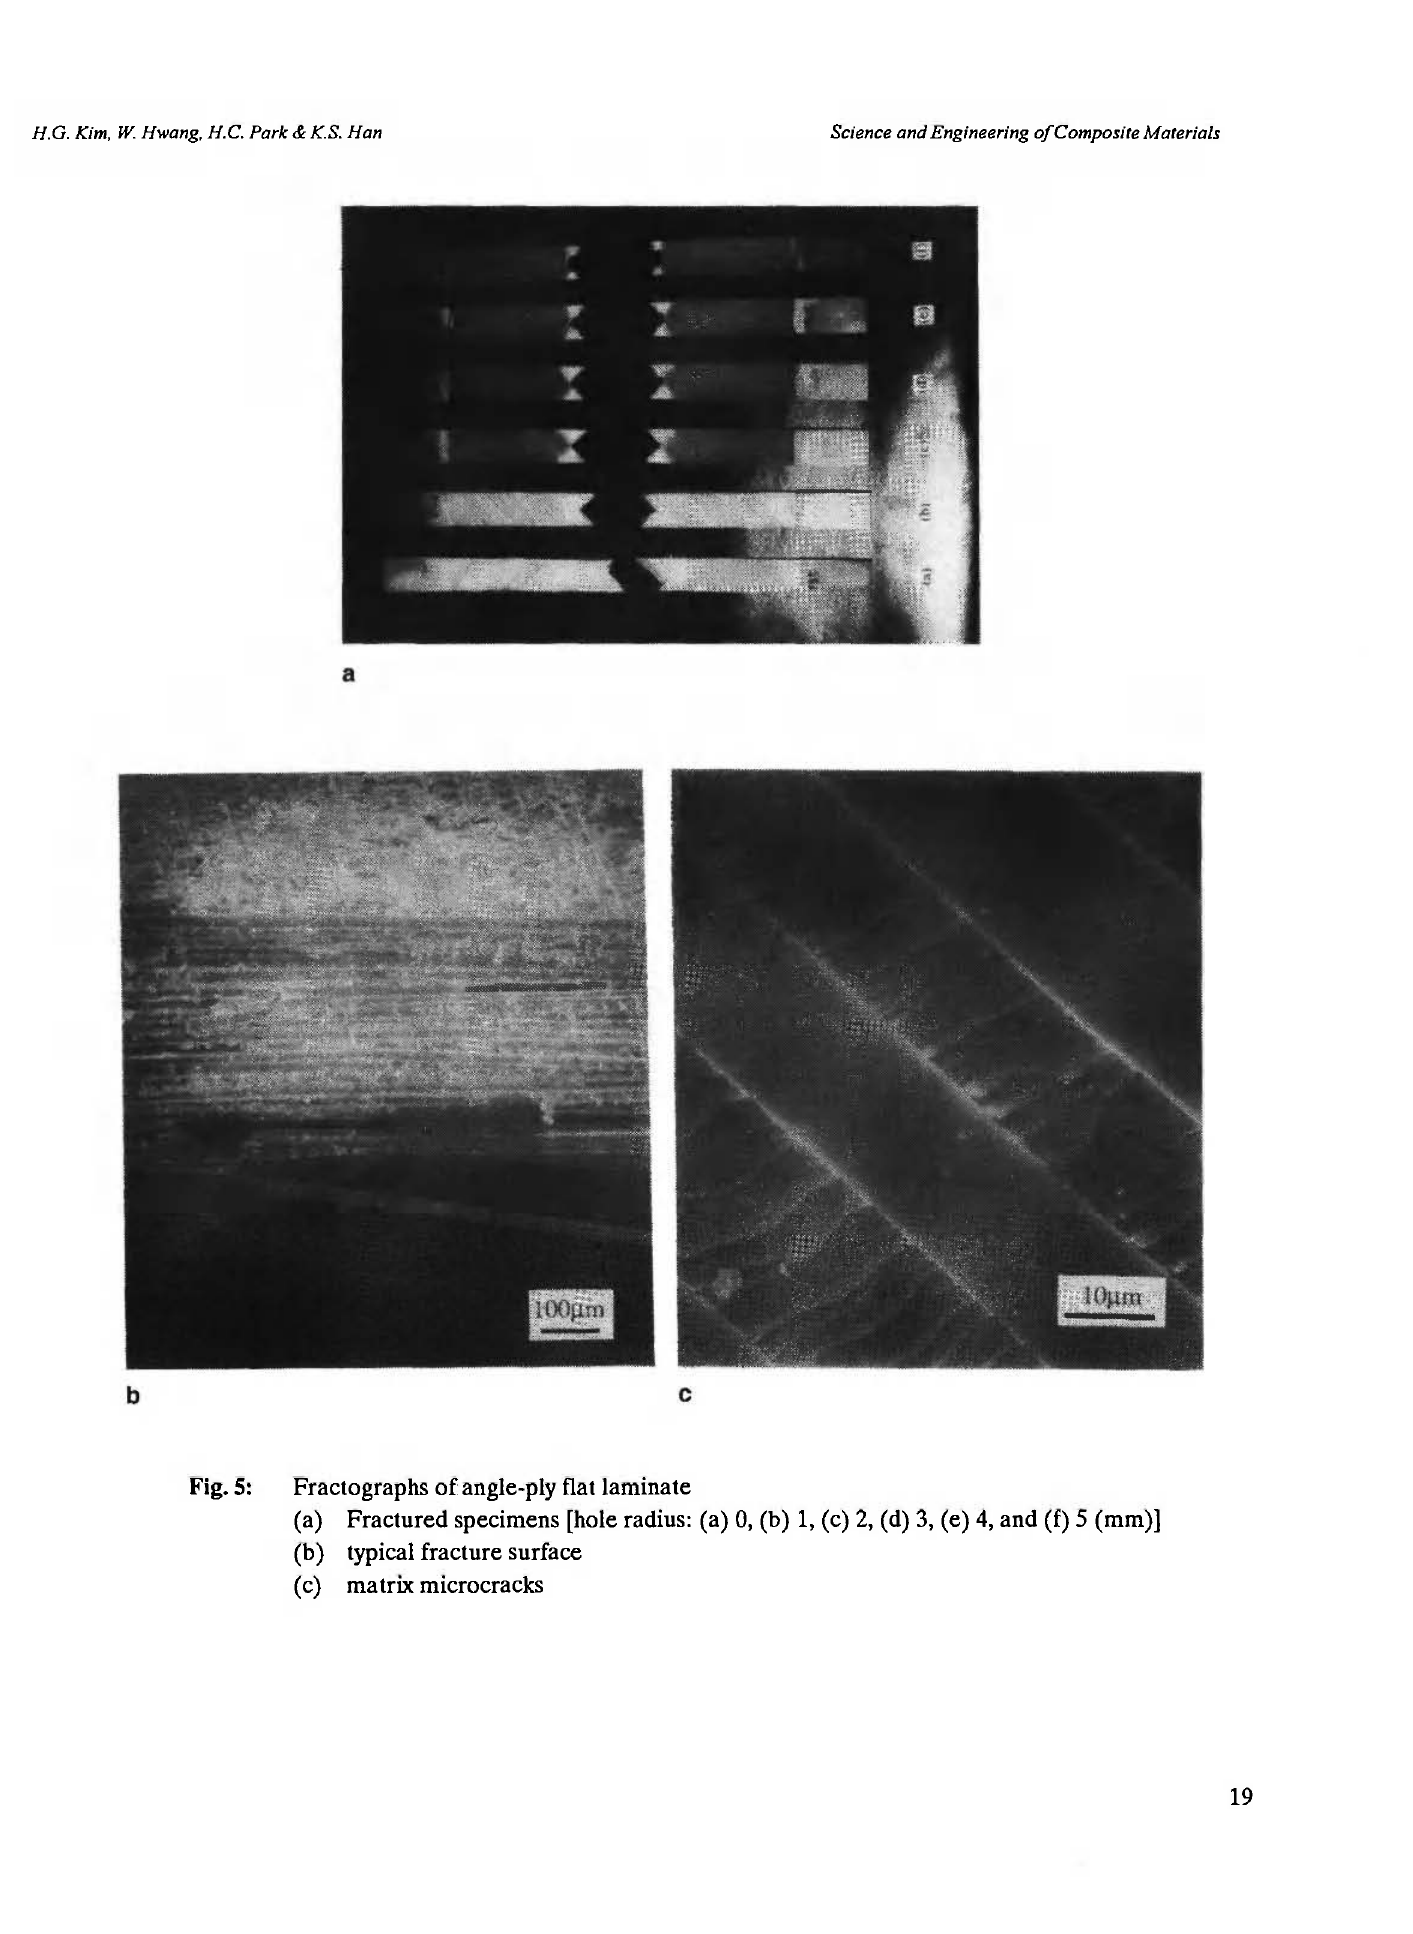
Fig. 5: Fractographs of angle-ply flat laminate (a) Fractured specimens [hole radius: (a) 0, (b) 1, (c) 2, (d) 3, (e) 4, and (f) 5 (mm)] (b) typical fracture surface (c) matrix microcracks